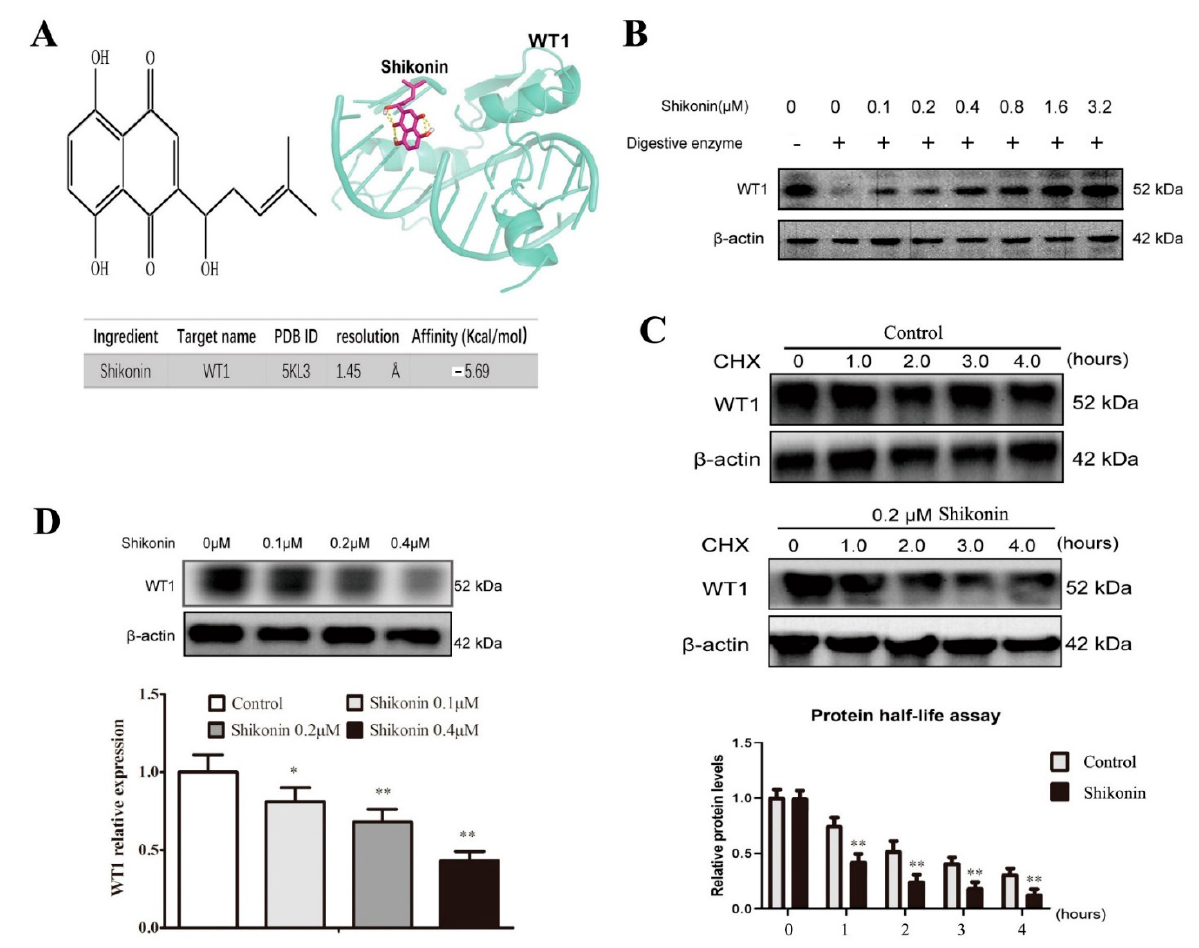
Figure 3. Shikonin is screened as a WT1 inhibitor. ( A ) The chemical structure of shikonin and its binding affinities to WT1 in molecular docking. ( B ) The binding of shikonin to WT1 in DARTS experiment. ( C ) The effect of shikonin on WT1 protein degradation was detected by the protein half-life test. ( D ) Shikonin suppressed WT1 protein expression indicated by Western blot in HL-60 cells (n = 3). Cells were incubated with shikonin for 48 h. The data were presented as the mean ± SD. * p < 0.05; ** p < 0.01 compared to the untreated control.